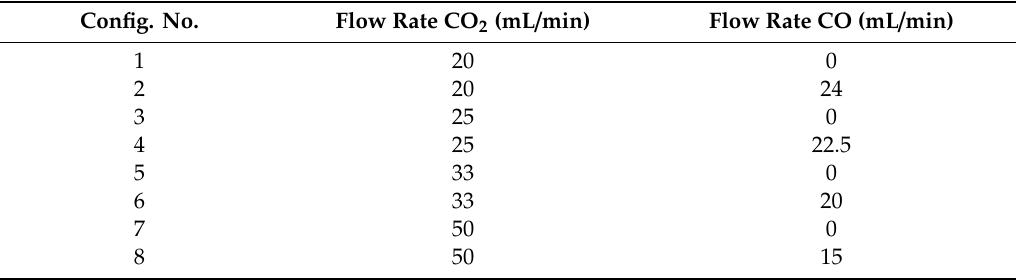
Table 2. Experiment configurations for CO 2 gasification; N 2 was added to yield a total gas flow of 100 mL / min.